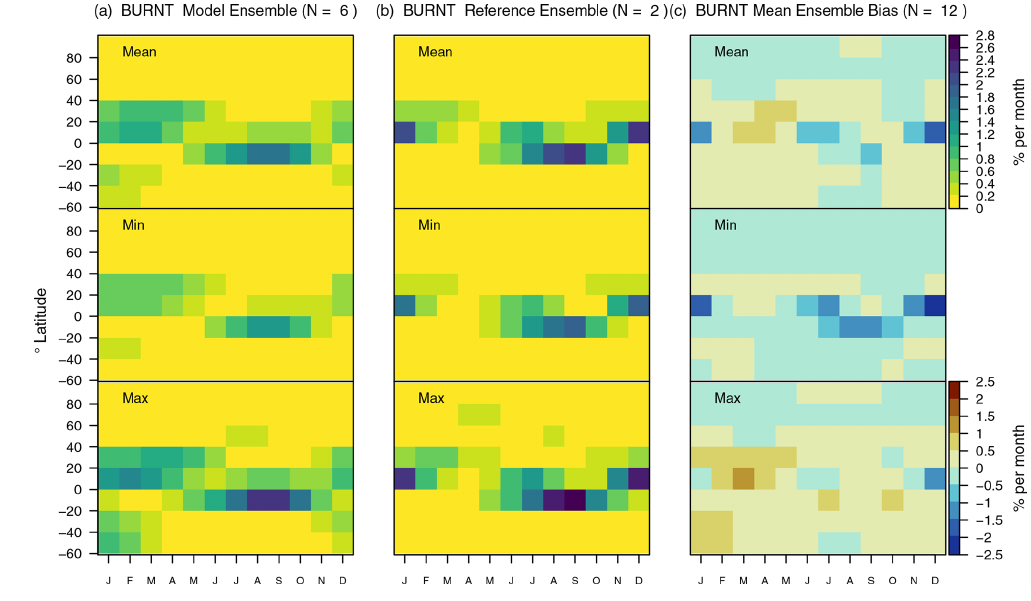
Figure A20. Same as in Fig. 8 but for fractional area burned.